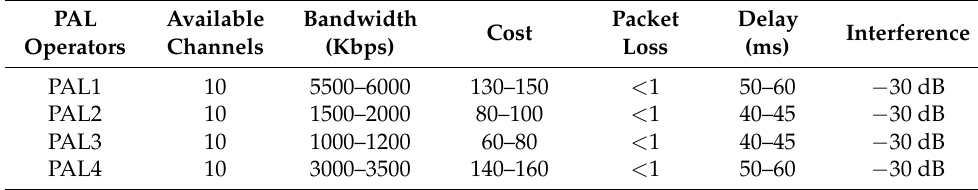
Table 7. Characteristics of PAL network operators.